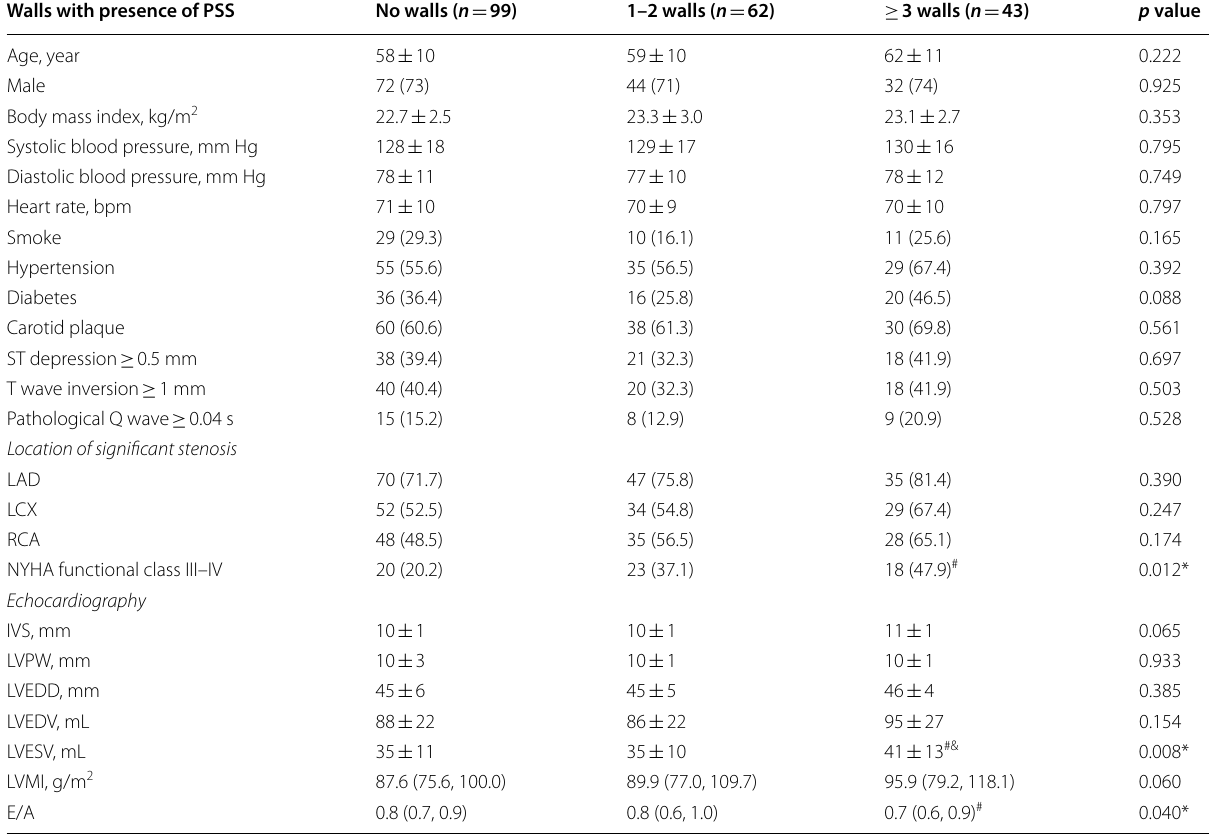
Data are presented as mean SD or median (interquartile range) for continuous variables, and count (%) for categorical variables ± LAD: left anterior descending artery; LCX: left circumflex artery; RCA: right coronary artery; NYHA: New York Heart Association; IVS: interventricular septum; LVPW: left posterior ventricular wall; LVEDD: left ventricular end-diastolic diameter; LVEDV: left ventricular end-diastolic volume; LVESV: left ventricular end-systolic volume; LVMI: left ventricular mass index; E/A: mitral inflow peak early velocity/mitral inflow peak late velocity; E/e ′ : mitral inflow peak early velocity/mitral annular peak early velocity; LVEF: left ventricular ejection fraction; GLS: global longitudinal strain # p < 0.05 versus no walls group. & p < 0.05 versus 1–2 walls